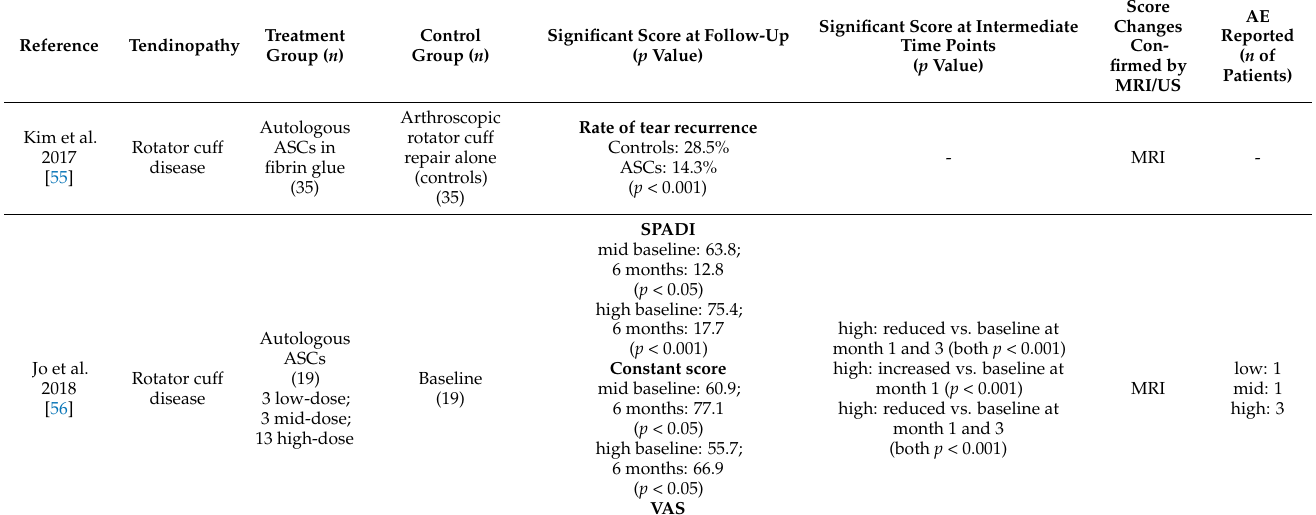
Table 3. Significant score changes and adverse reactions following intratendinous injections of ASCs, reported by the studies included in this systematic